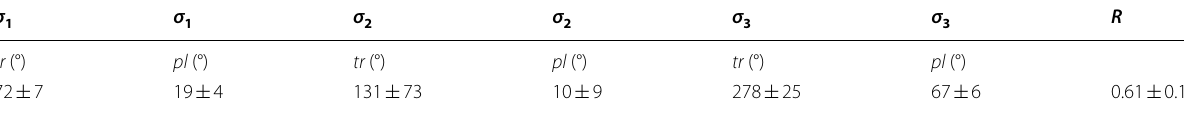
Table 1 Principal stresses averaged over the aftershock